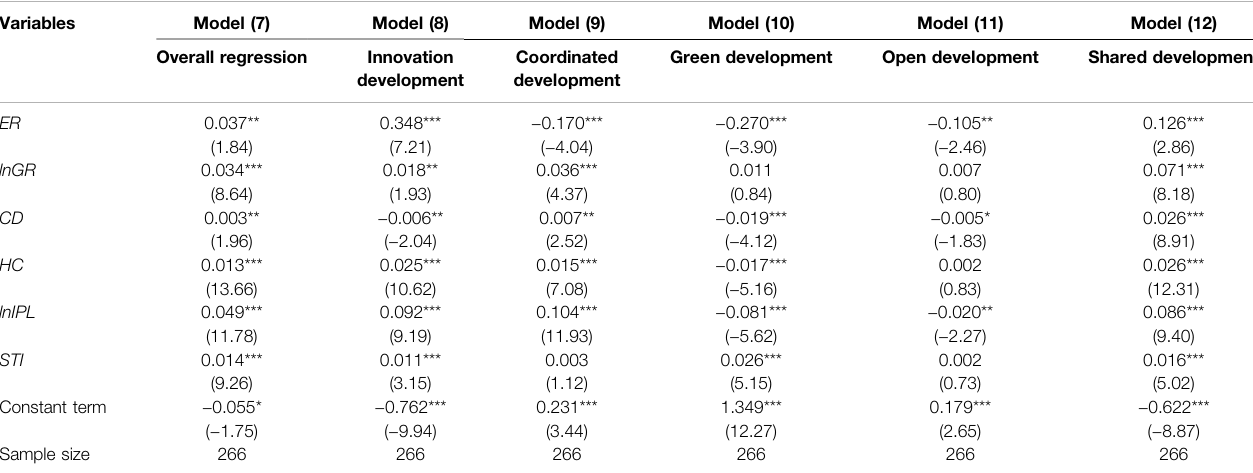
TABLE 8 | Robustness test estimates — OLS